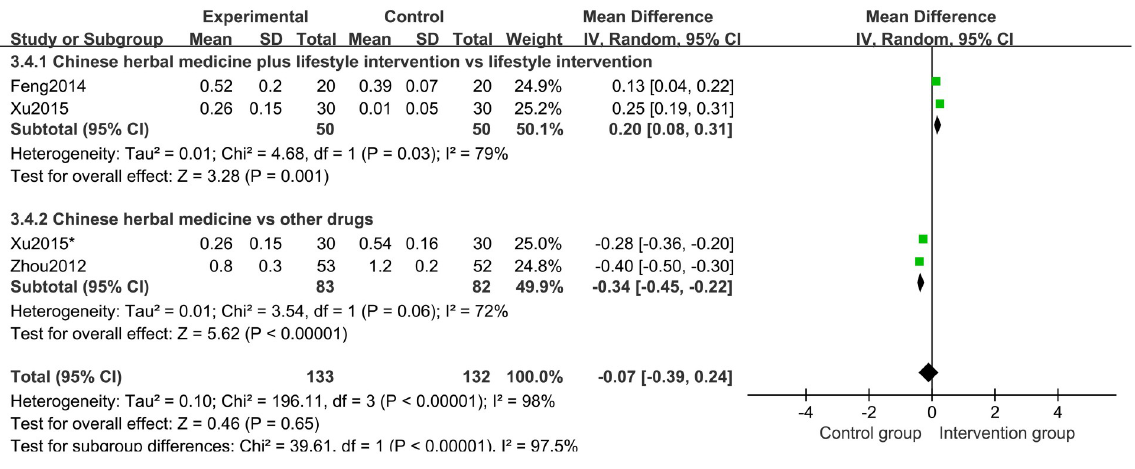
Fig 14. Subgroup analysis of Δ HtSDS based on the